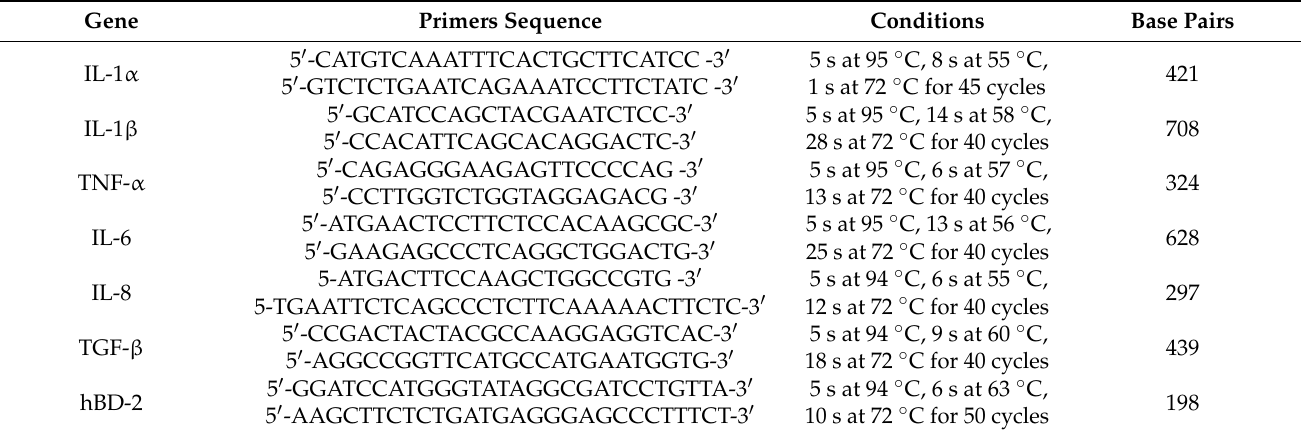
Table 1. Analyzed genes involved in the immune response of HaCaT cells seeded on PVA/G sponges. Gene Primers Sequence Conditions Base